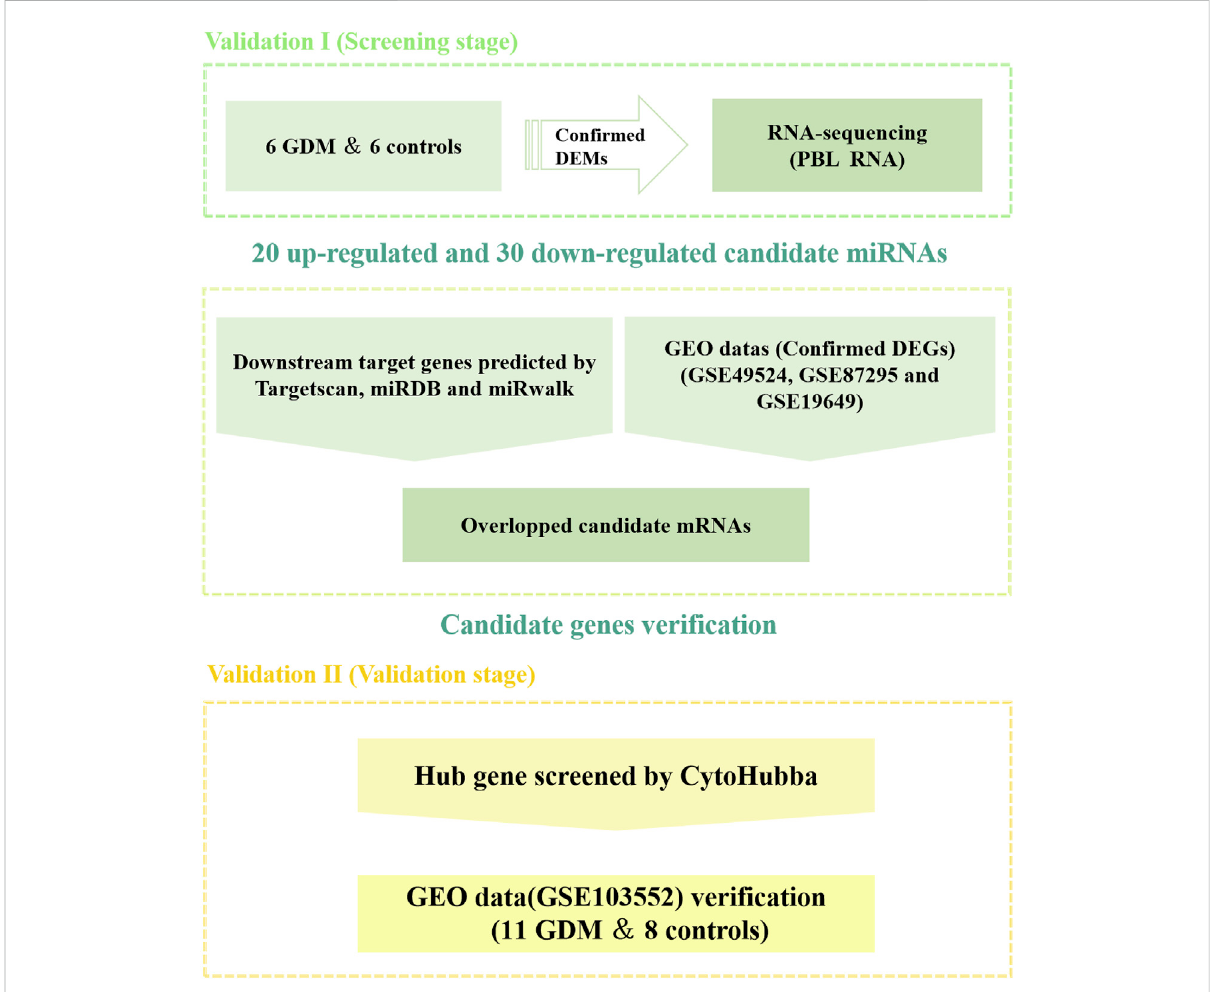
FIGURE 1 Schematic of study